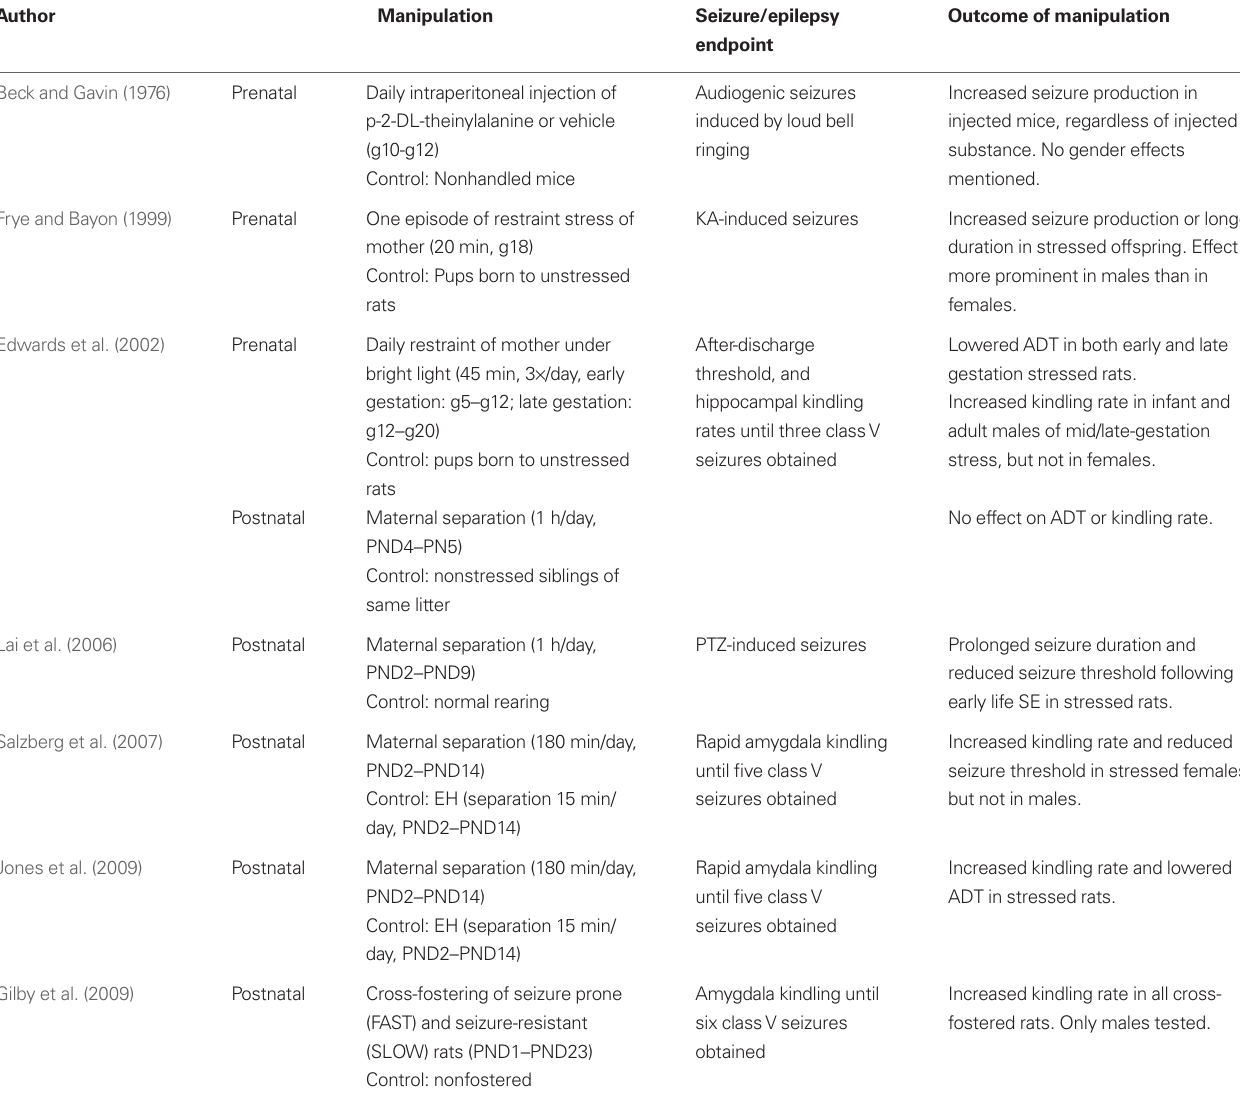
Table 1 | Overview of studies investigating effects of early life stress in rodent models of